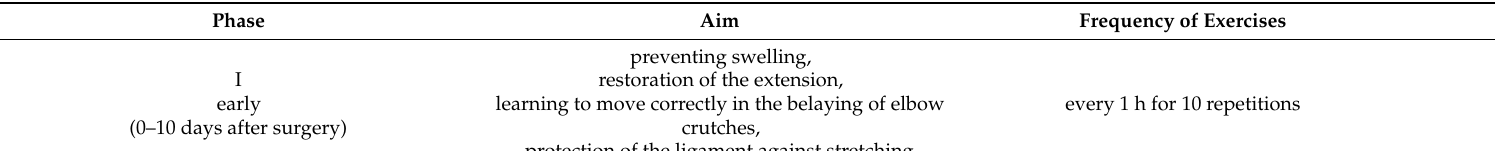
Table 1. Rehabilitation treatment